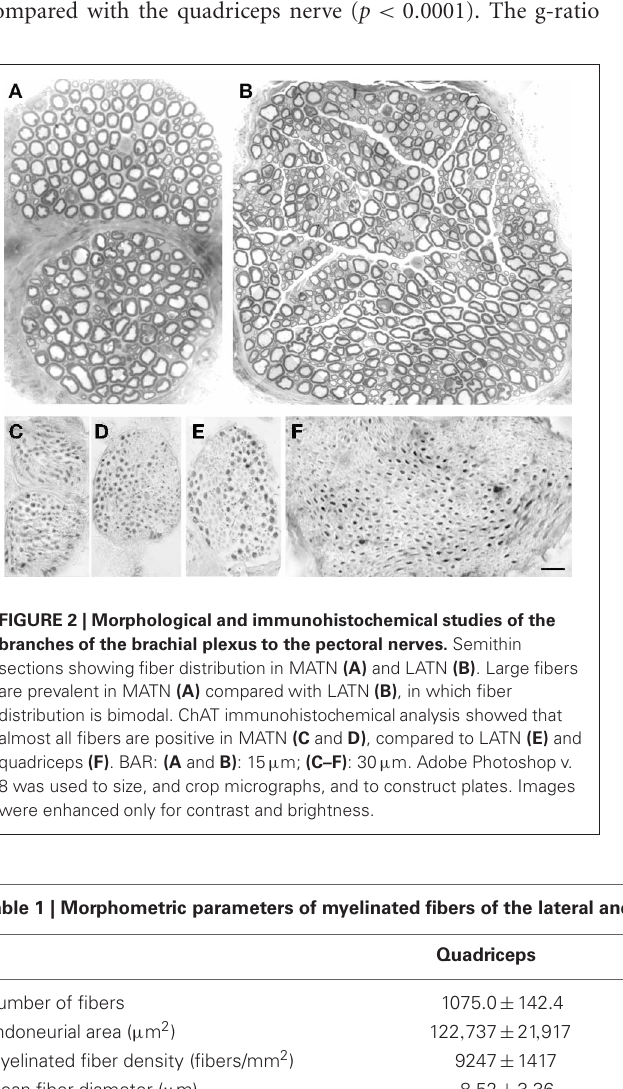
Data are mean ± SD. % ChAT + , percentage of choline acetyltransferase-positive fibers. * p < 0 . 05 vs. quadriceps; ** p < 0 . 005 vs. quadriceps; *** p < 0 . 0005 vs. quadriceps. # p < 0 . 05 vs. lateral anterior thoracic; ### p < 0 . 0005 vs. lateral anterior